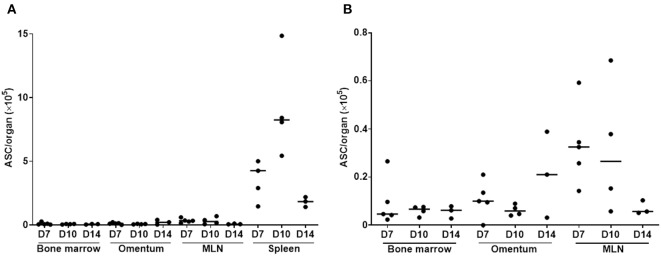
Antibody-secreting cells in lymphoid organs after sepsis. Sepsis was induced by CASP-operation in female C57BL/6 mice. At the indicated time points bone marrow, omentum, mesenteric lymph nodes (MLN) and spleen were harvested and cells isolated. Antibody-secreting cells (ASC, sum of IgM and IgG) per organ were measured with an ELISpot, and the median is depicted (A). ASC/organ values below 1 × 105 for bone marrow, omentum and MLN are separately shown (B). N = 3–5.